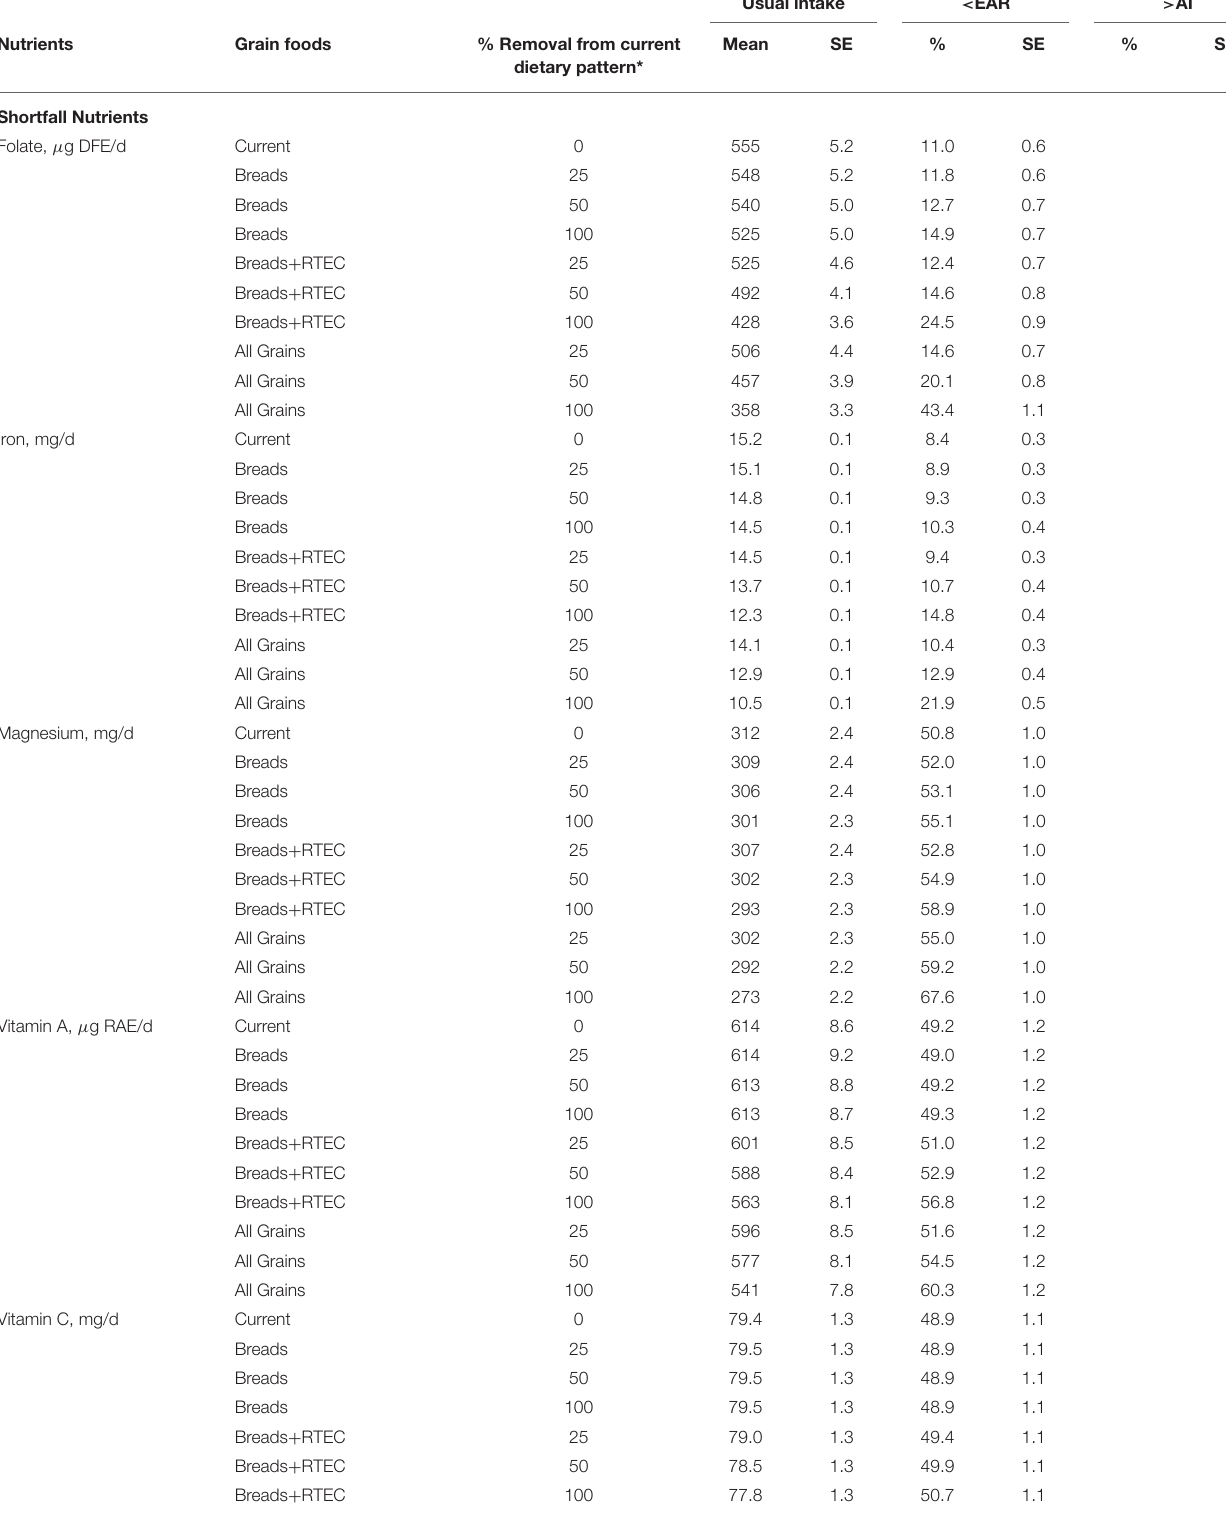
TABLE 4 | Shortfall nutrients: mean usual nutrient intakes percentages meeting recommendations in 19–50-year-old adults.